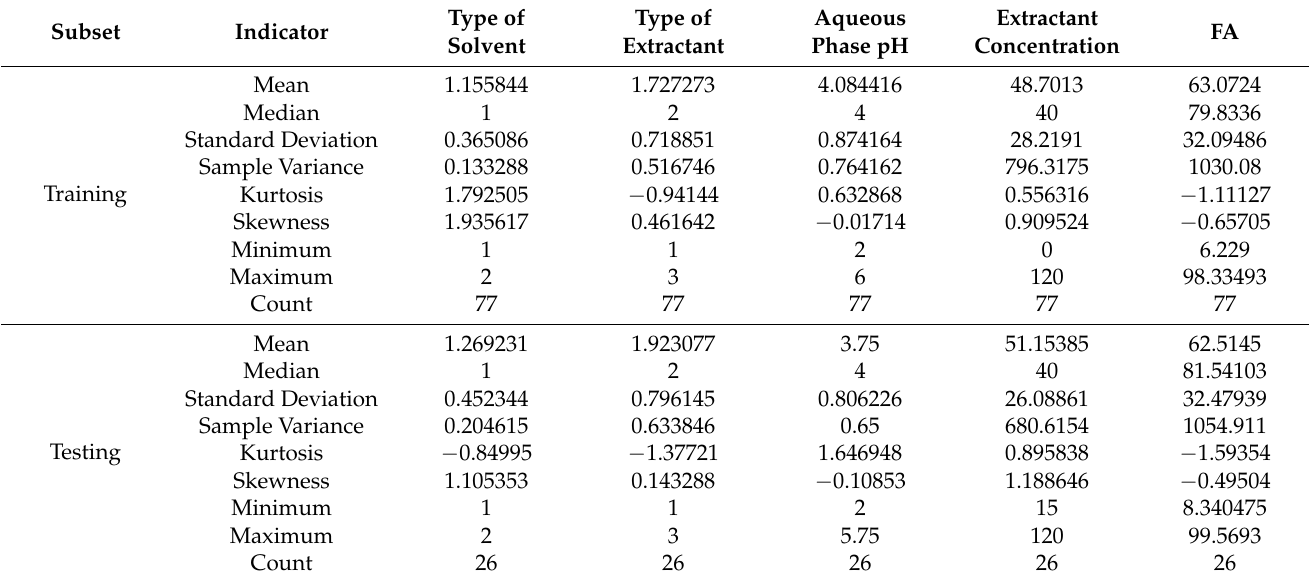
Table 3. Statistics descriptors for the subsets used for ANN training and testing.